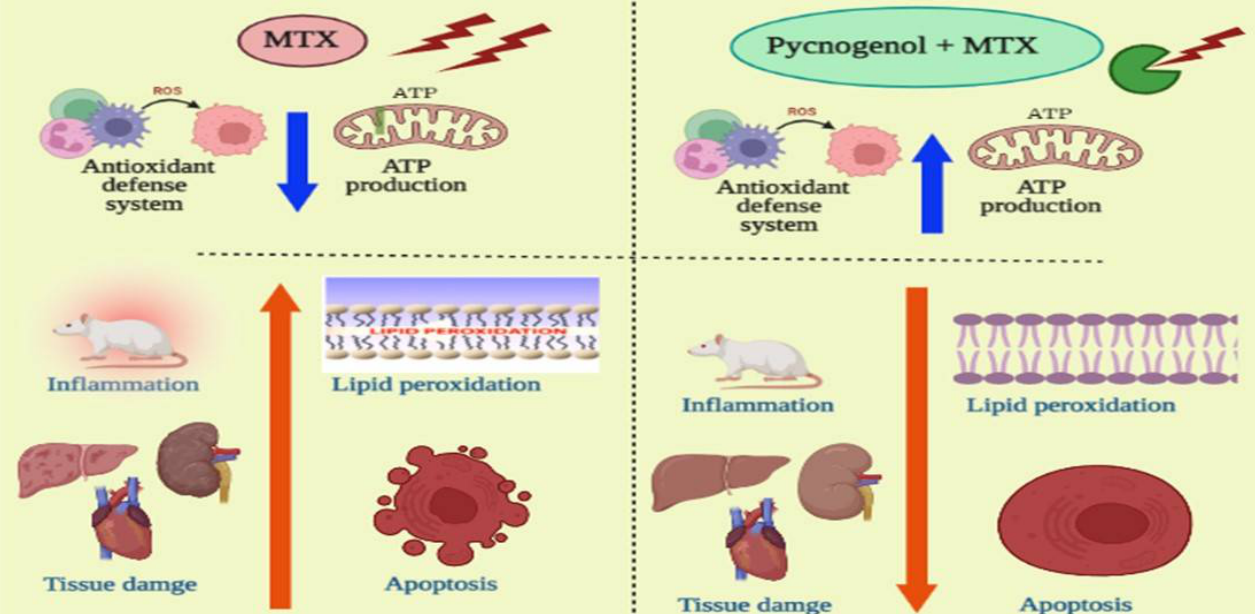
Figure 11. Illustration of the protective effect of pycnogenol on MTX-induced toxicity in different organs.